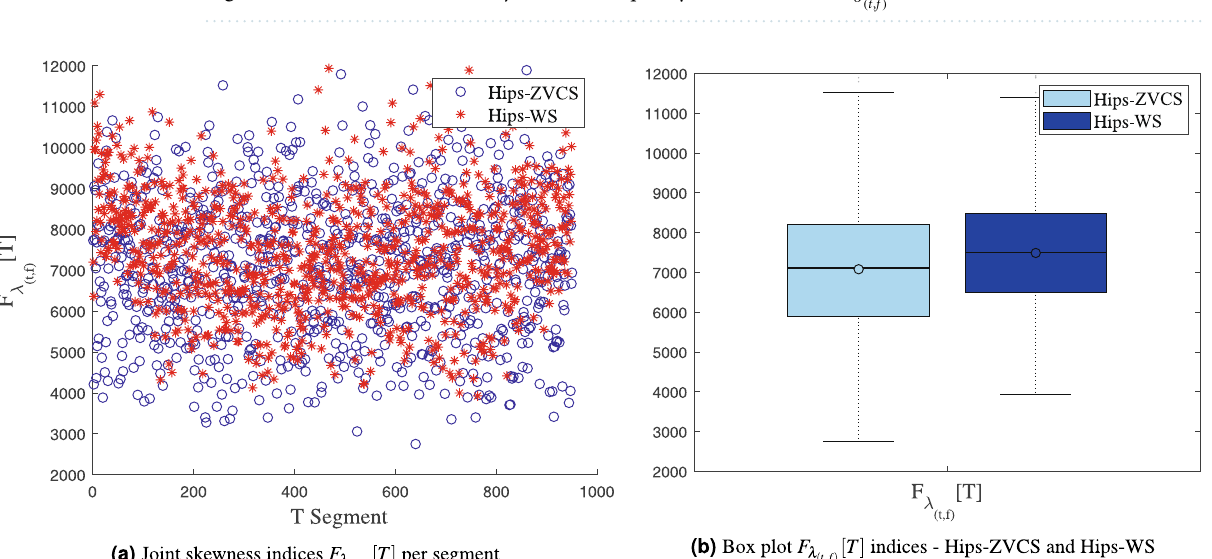
Figure 5. Distribution of the the joint time-frequency moment indices F σ 2